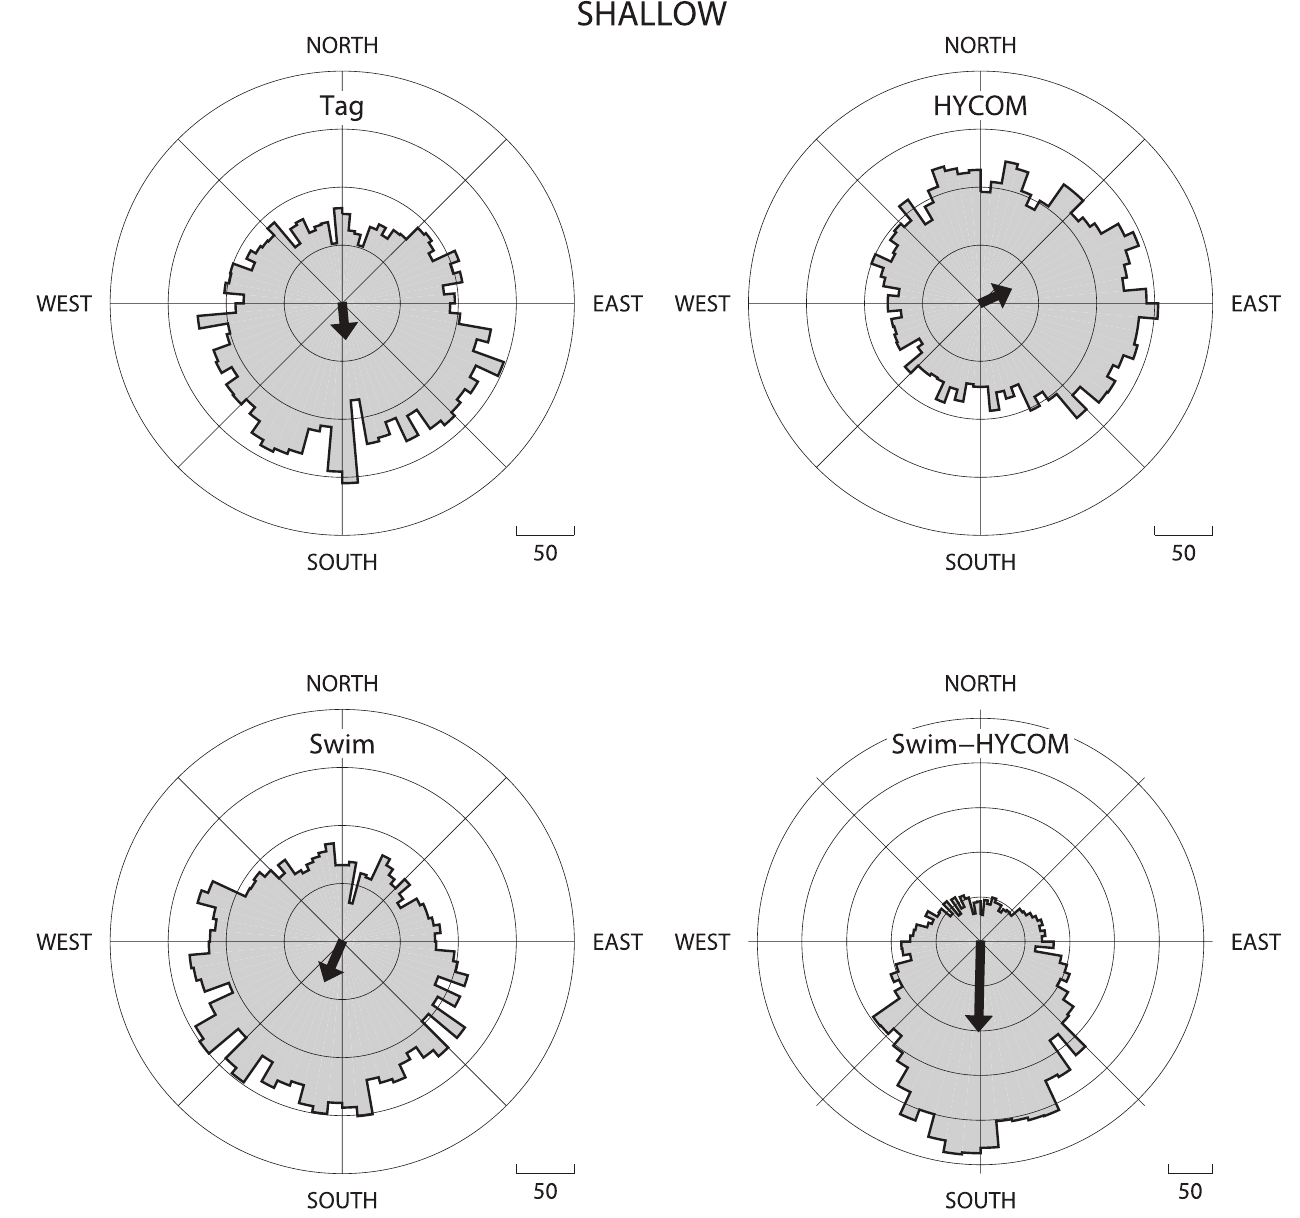
Figure 4. Tabulations of daily satellite tag displacement, HYCOM shallow currents, and inferred swimming direction. The swimming direction differencing to HYCOM shallow currents shown in the lower right panel is a relative direction where North is the direction of the HYCOM surface current and South is against the direction of the HYCOM surface current. Average unweighted resultant vector is plotted for each tabulation.